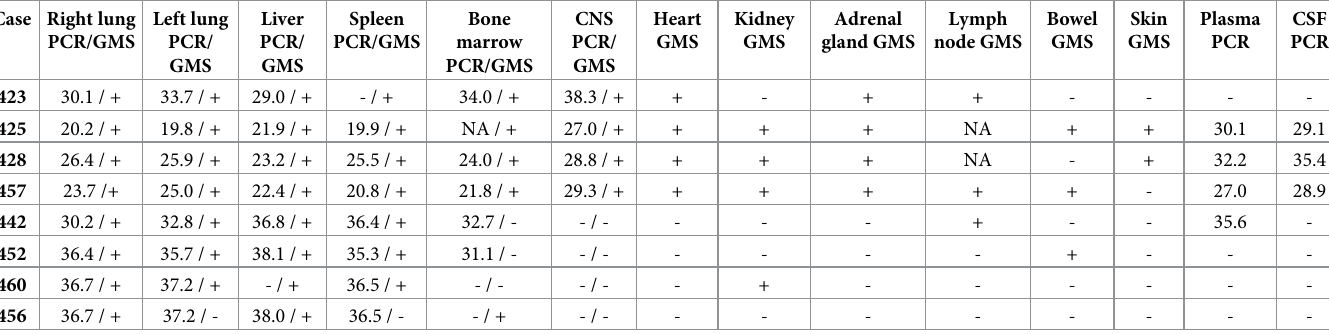
Cycle threshold (Ct) values of the Histoplasma real-time PCR assay are indicated in positive samples. Samples in which histoplasma DNA was not detected are shown as -; CNS: central nervous system; CSF: cerebrospinal fluid; NA: not